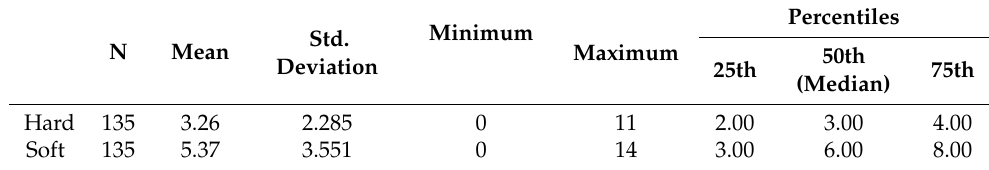
Table 18. Descriptive statistics of hard and soft skills within administrative positions only.